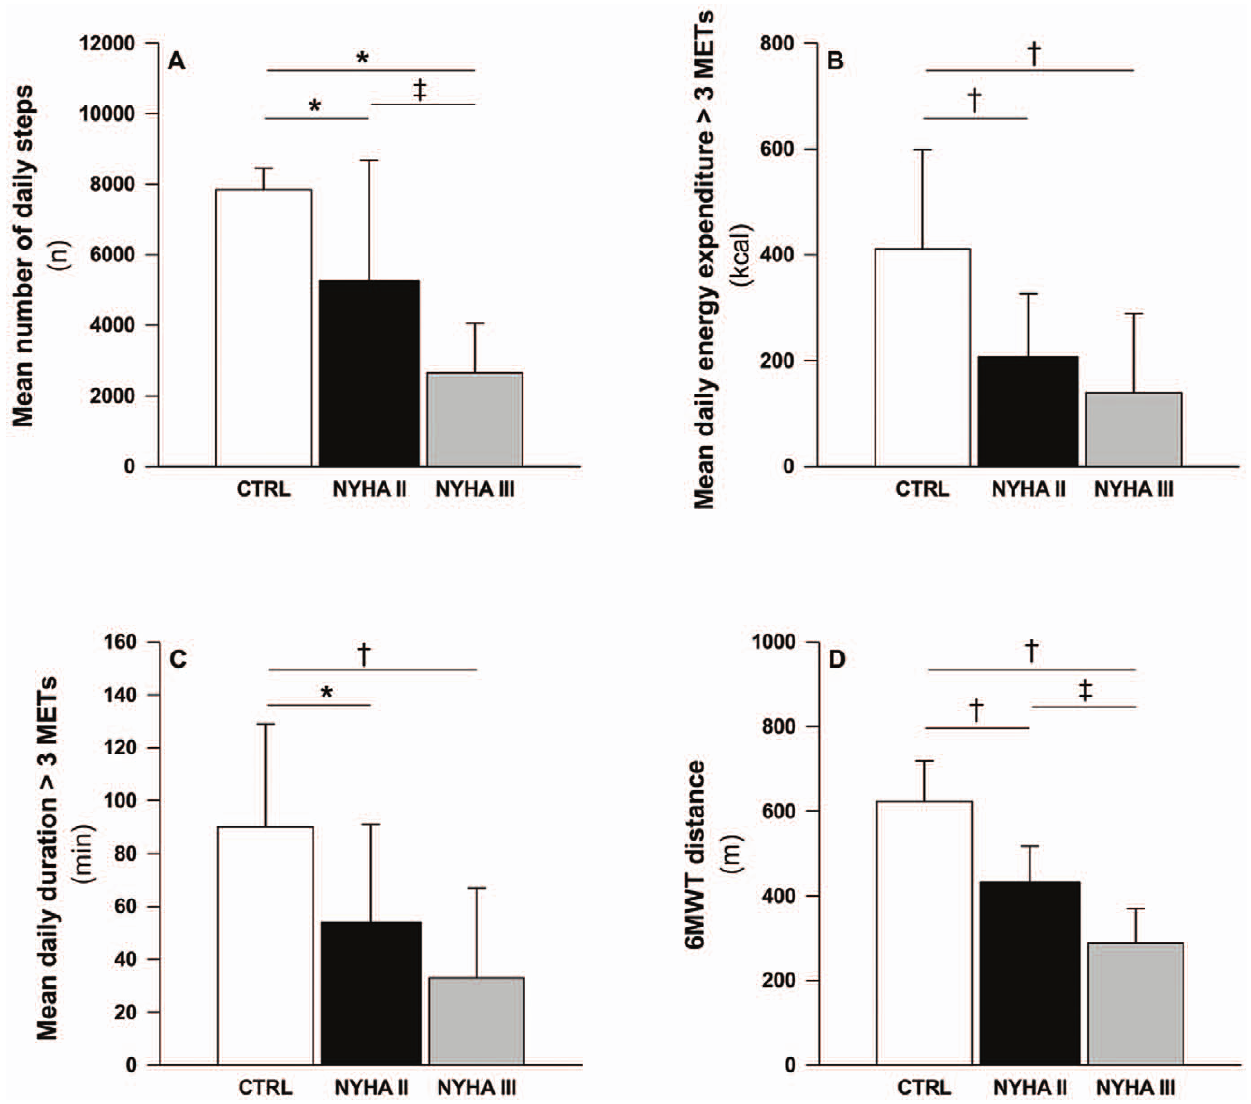
Figure 3. Relation between daily life physical activities and exercise capacity with the New York Heart Association functional class. Mean number of daily steps (panel A), mean daily energy expended during physical activities inducing a metabolic demand . 3 METs (panel B), mean daily duration of physical activities inducing a metabolic demand . 3 METs (panel C), and six-minute walk test (6MWT) distance (panel D) in healthy control subjects (CTRL; open bars) and in patients with pulmonary arterial hypertension in New York Heart Association (NYHA) functional class II (dark bars) and III (grey bars). Values are mean (SD). * p , 0.05 and { p , .001 vs. CTRL; { p , 0.001 vs NYHA II. Figure legend: n, number; kcal, kilocalories; min, minute; m;